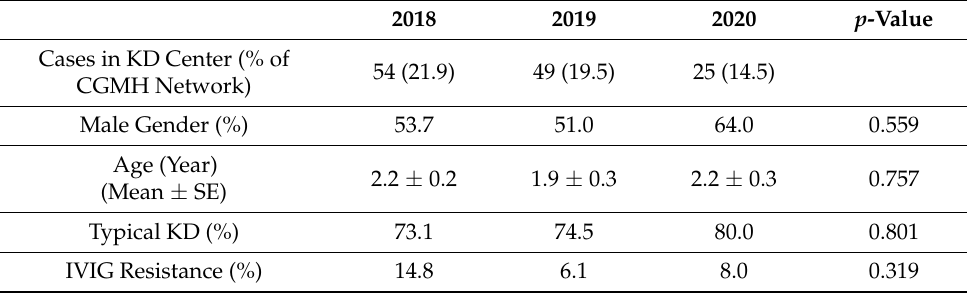
Table 2. Baseline characteristics of patients with Kawasaki